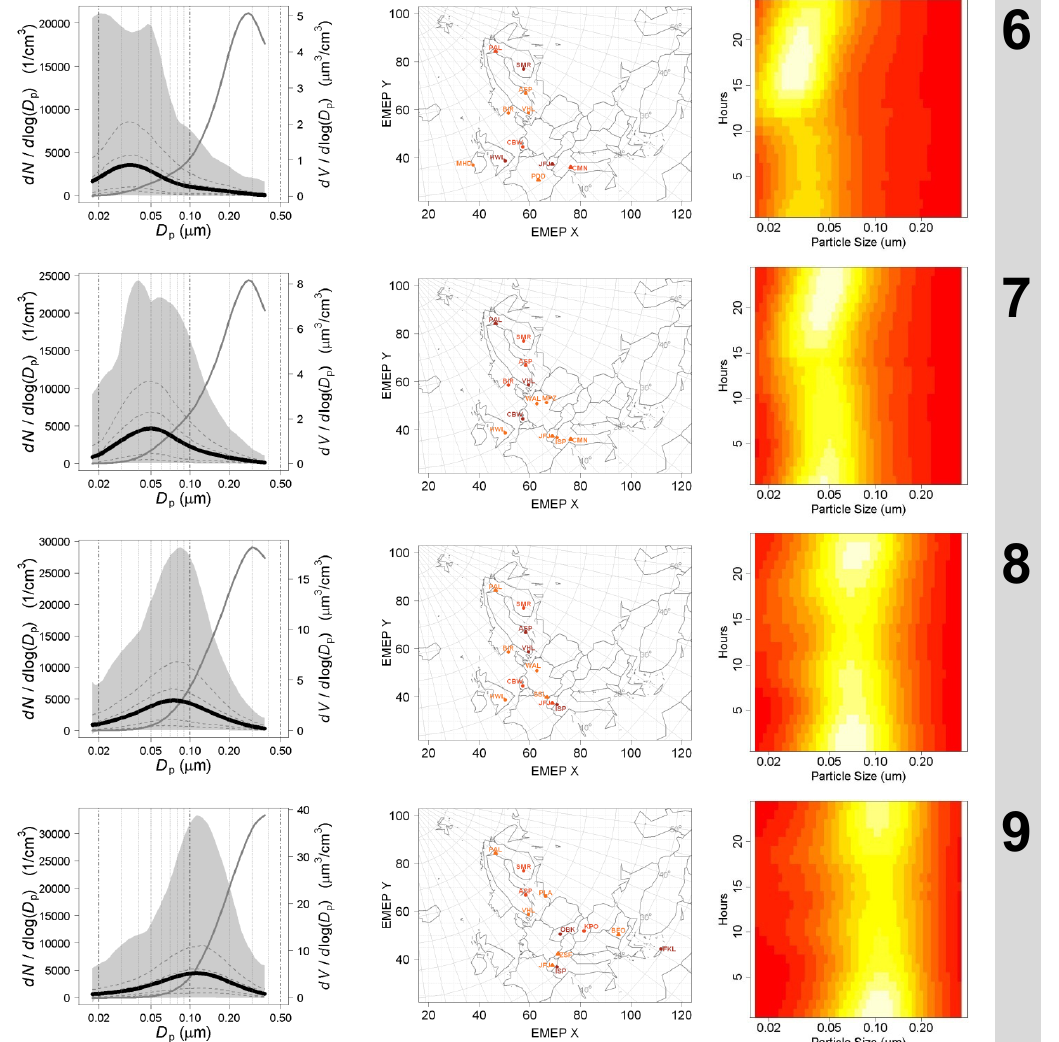
Figure 4. Average clustered particle size distributions ( cluster 1-9 left hand panels ) and the spatial distribution of each cluster ( centre panels ). The solid black line shows the average spectrum and the dashed lines show the 10 th , 25 th , 75 th and 90 th percentile spectrum. The maximum and minimum spectra are traced out by the extremities of the shaded areas. The middle panels show where each of the clusters are most likely to be detected. When counting the spectrum types within the whole data set, the sites which collected above the 90 th , 75 th and 50 th percentile were marked with a progressively lighter orange colour (see Figure S5 for the frequency distributions). Circles denote boundary layer sites and triangles denote sites of relatively high altitude. The right hand panel shows the colour maps plotted using the average day of hourly spectra for each of the clusters. [The shade from red-yellow-whites represent a linear scale of d N / dlog( D p ) between the minimum value of the 10 th percentile spectrum and the maximum value of the 90 th percentile spectrum shown for each